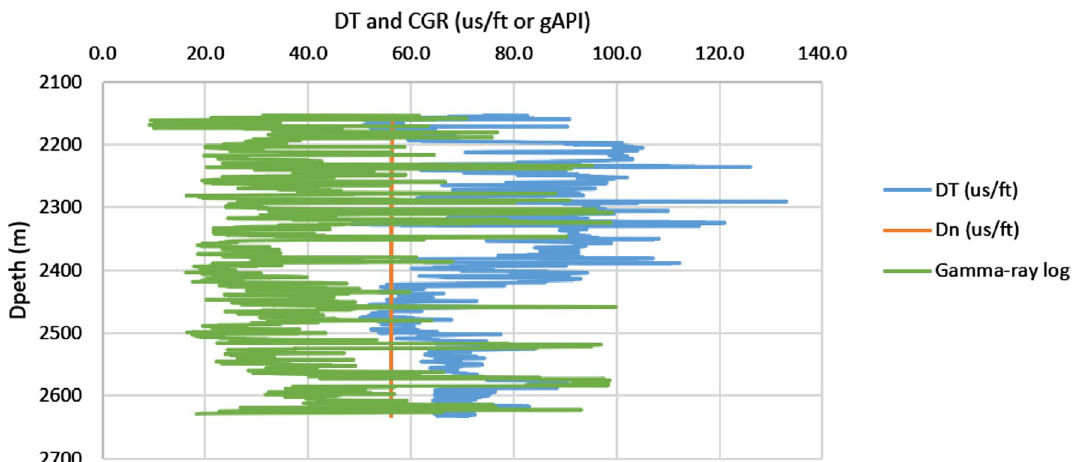
Fig. 3 The sonic log (blue), normal sonic log (red) and gamma ray are sketched versus depth (vertical axis) in the overpressure area at well no.